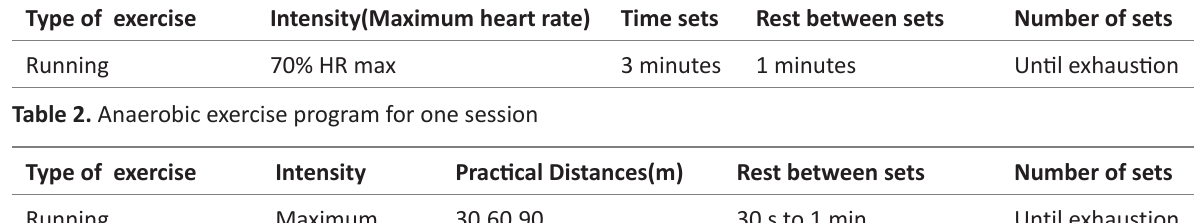
Table 1. Aerobic exercise program for one session Type of exercise